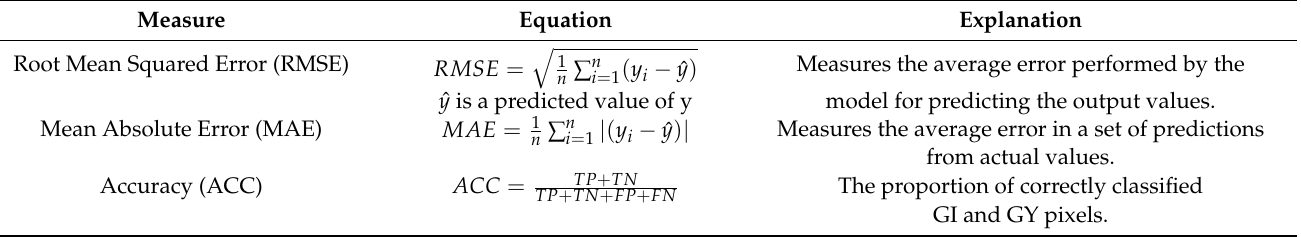
Table 2. Statistical index-based evaluation measures used for the assessment of models.